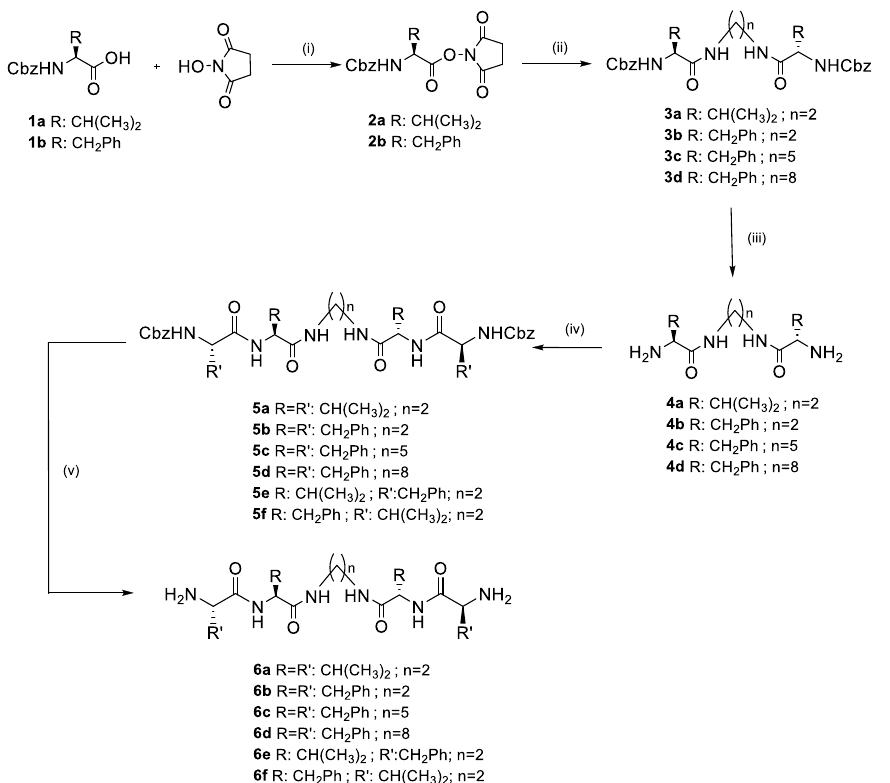
Table 1. Gelation properties of compounds 6a – f in aqueous solutions 1 . Entry Comp. Solvent(s)